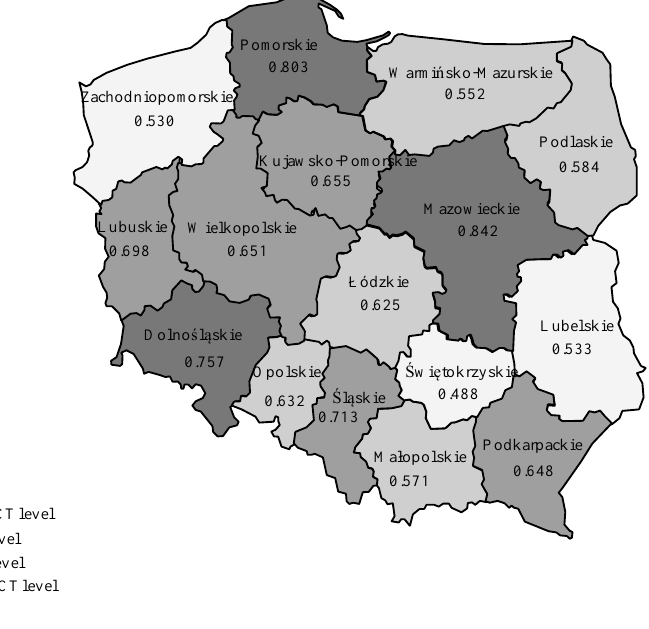
Figure 1. Results of the grouping of provinces according to the level of information infrastructure in